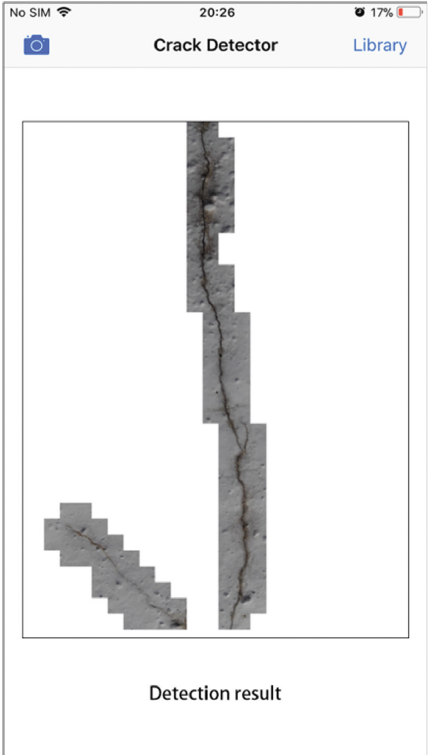
Figure 14: Detection result of the Crack